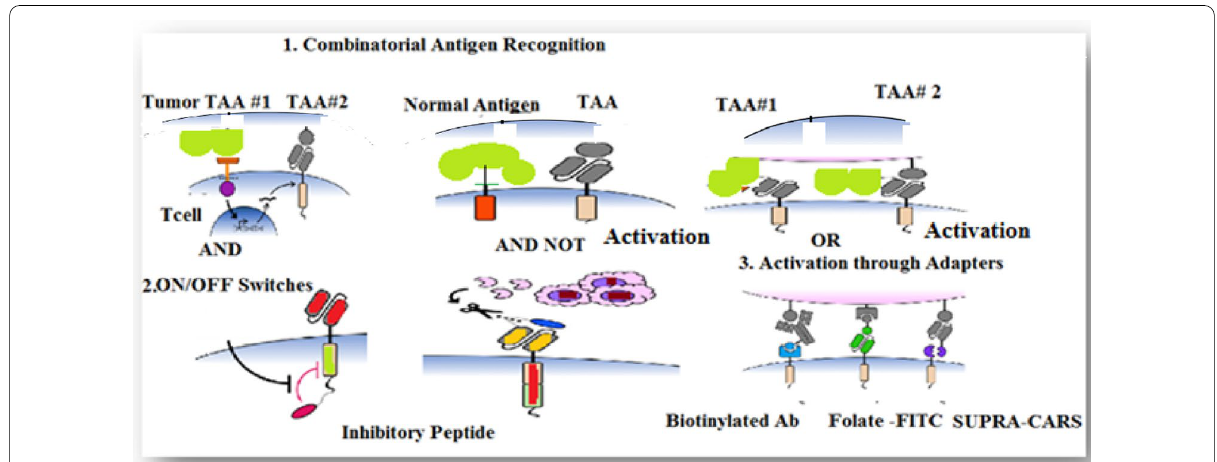
Fig. 2 Protein designing methodologies to enhance the safety, program, and effectiveness of chimeric antigen receptor 1. Antigen recognition via AND and AND-NOT logic, respectively, can improve binding ability and efficiency. 2. Chimeric antigen receptor-T cell activity may be rapidly and effectively changed with ON/OFF switches. 3. Chimeric antigen receptors to activate only when an adapter is assembled can provide chimeric antigen receptor-T cells more control over their